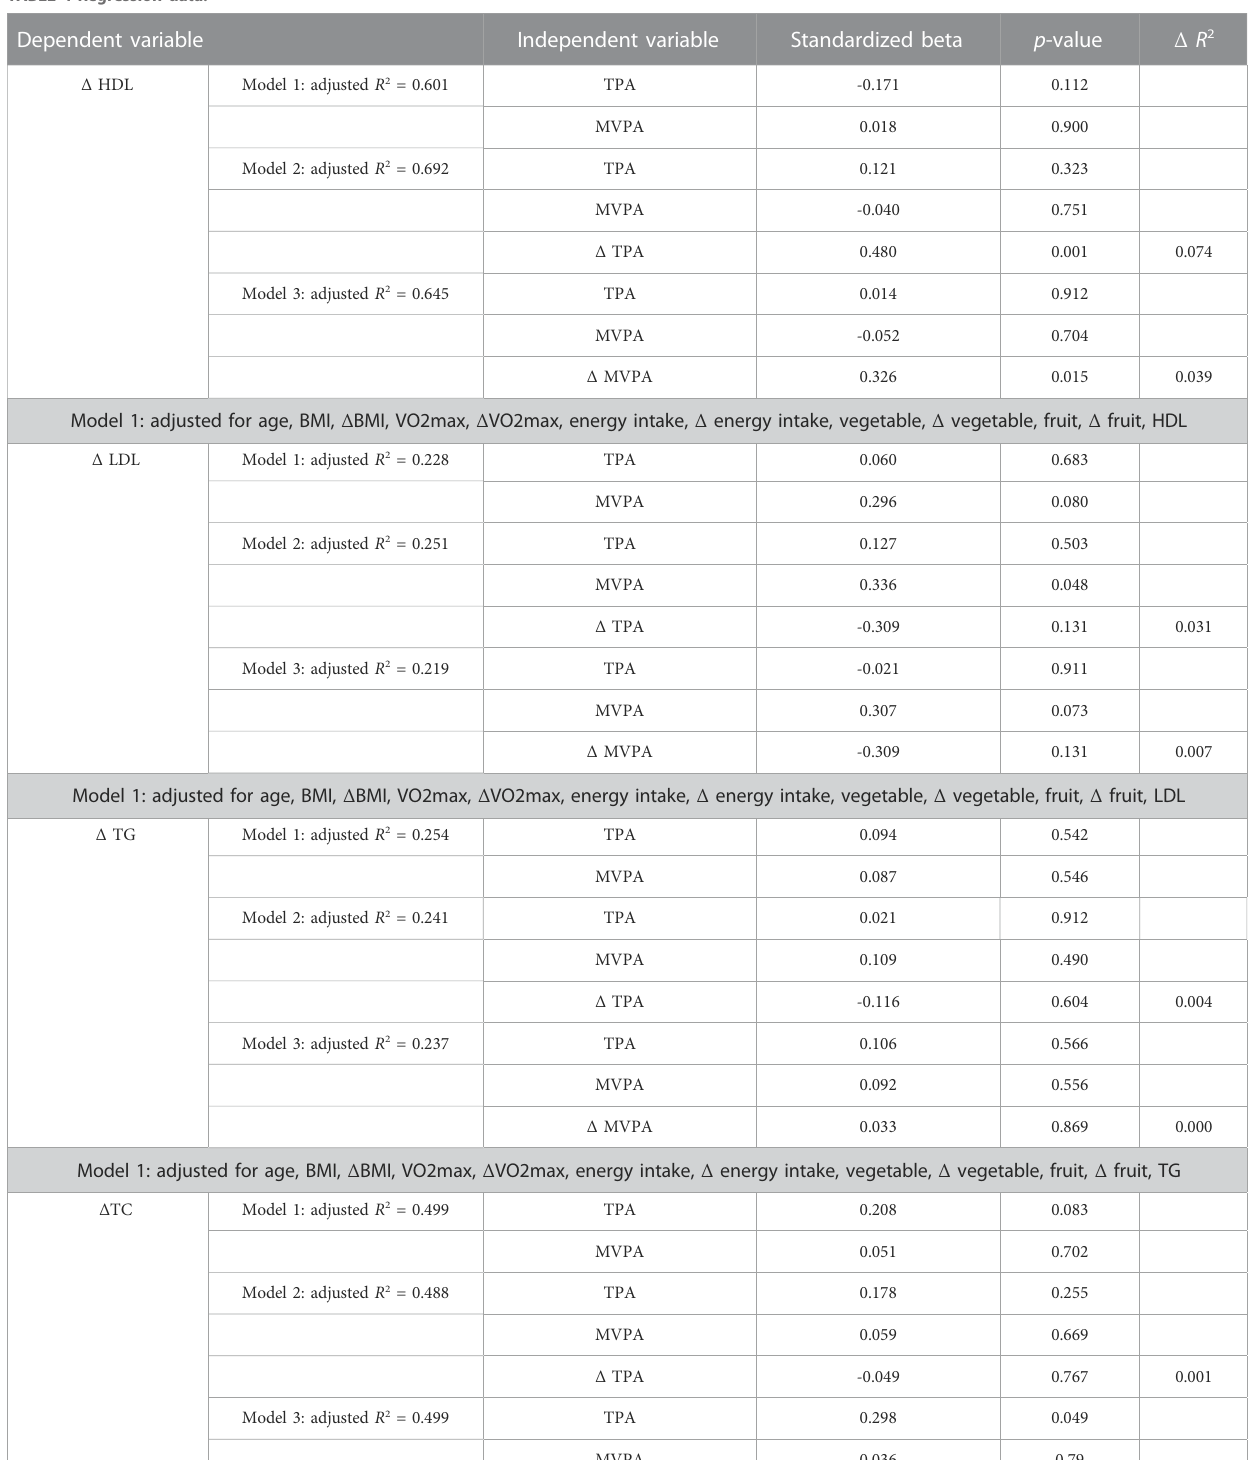
TABLE 4 Regression